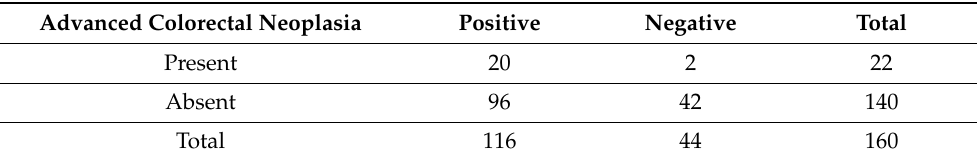
Table 3. The diagnostic accuracy of the faecal immunochemical test for the detection of advanced colorectal neoplasia in kidney transplant